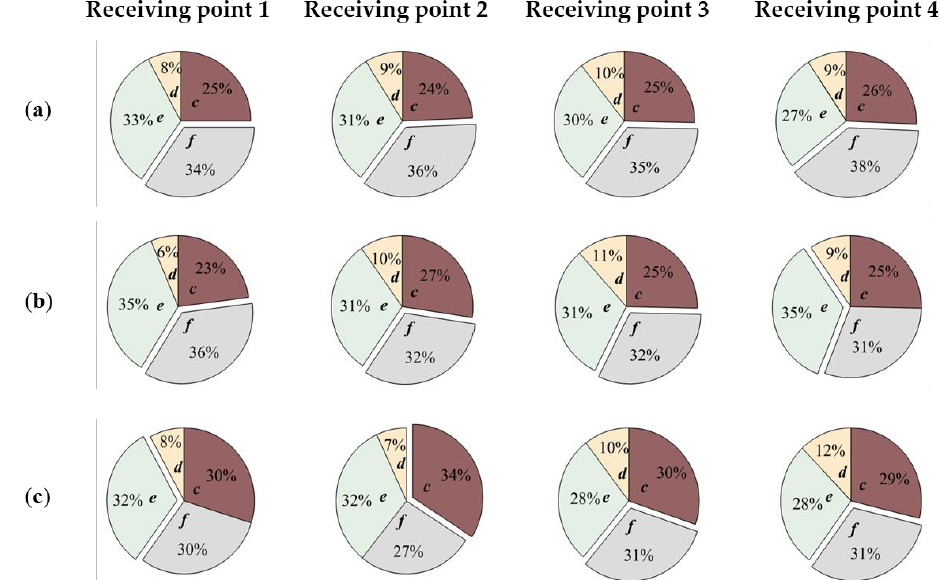
Figure 7. The spatial sound field auditory changes for different wall absorption coefficients for the three musical sounds. The colors represent different spatial models: green, gray, red, and yellow correspond to e, f, c, and d models. The size of the fan indicates the number of the stimuli selected at a receiving point in this space; the larger the number being selected, the larger the fan area. ( a ) Flute; ( b ) Violin; ( c ) Symphony.